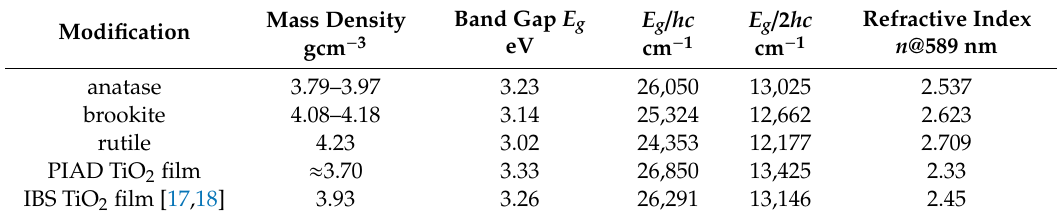
Table 1. The crystal refractive indices indicated in Table 1 are polarization-averaged. Table 1. Mass density, band gap energy, and refractive index of selected TiO 2